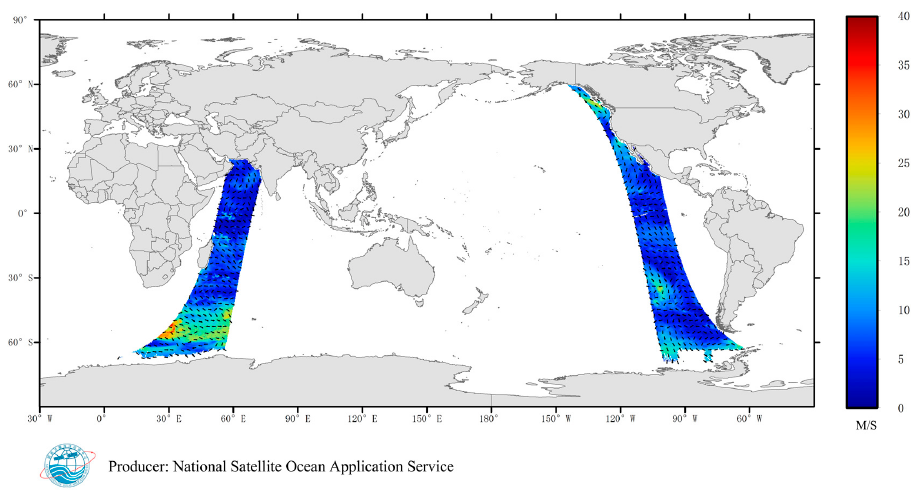
Figure 5. An Ocean Wind Field thematic map of a single HY-2A swath for 25 March 2015 derived from the HY-2A CAPF. The ocean wind vectors are mapped to a 0.25-degree grid. The lines and arrows show the wind direction; the colors show the wind speed.